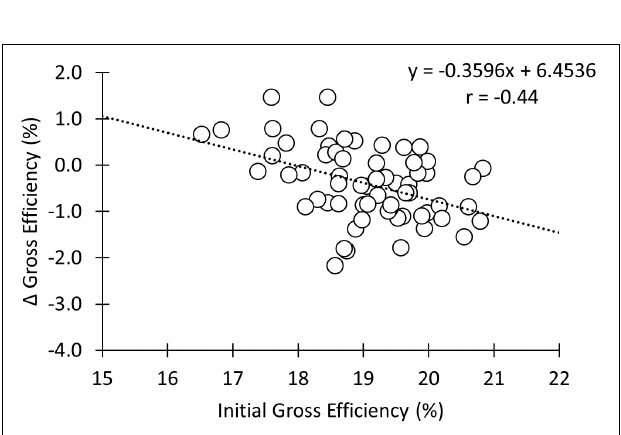
FIGURE 4 | Correlation between the percentage change in gross efficiency during the training intervention and initial gross